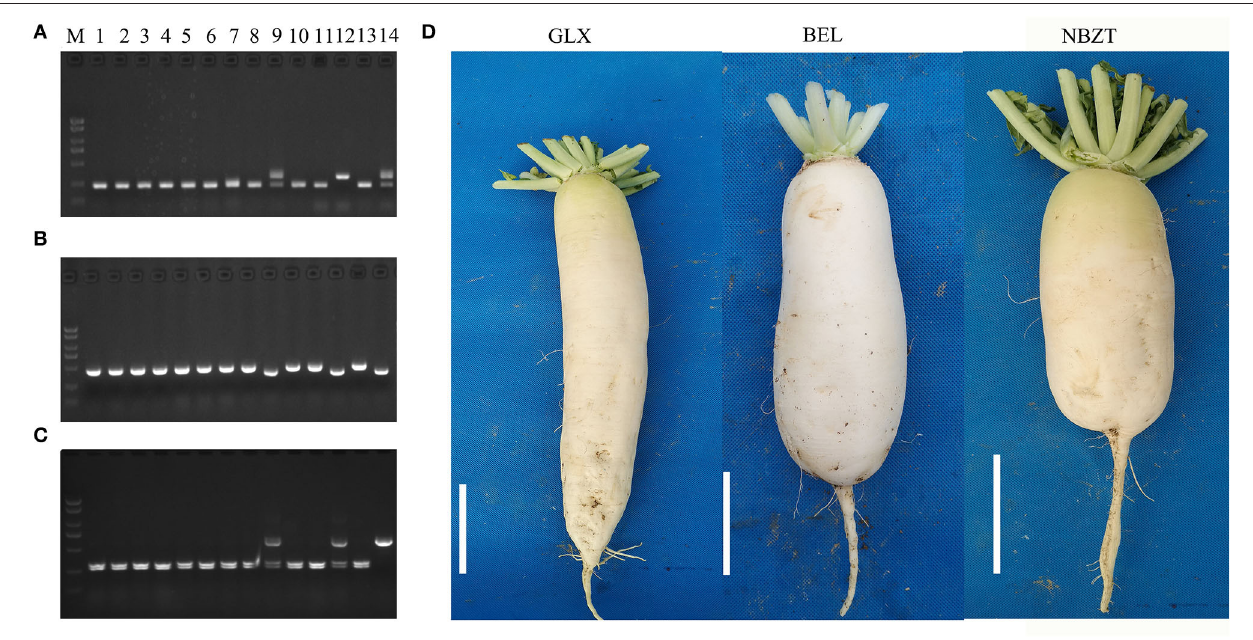
FIGURE 6 | Development of molecular markers based on three major QTLs of clubroot resistance loci. (A) Development of InDel molecular marker HB167 in resistance locus Rs5. (B) Development of InDel molecular marker HB220 in resistance locus Rs9. (C) Marker-assisted selection of molecular marker HB321 in resistance locus RsCr6 on chromosome Rs8. (D) Photograph of radish materials containing the resistance bands in three clubroot-resistant (CR) QTLs. The phenotypes of 14 radish breeding materials are presented in Table S4 , with “S,” “R,” and “H” indicating susceptible, resistant, and heterozygous individuals, respectively. “M” represents the 2kb marker. The numbers represent 14 radish breeding materials. “GLX,” “BEL,” and “NBZT” are the common name of three selected resistant clubroot materials. Bar scale =